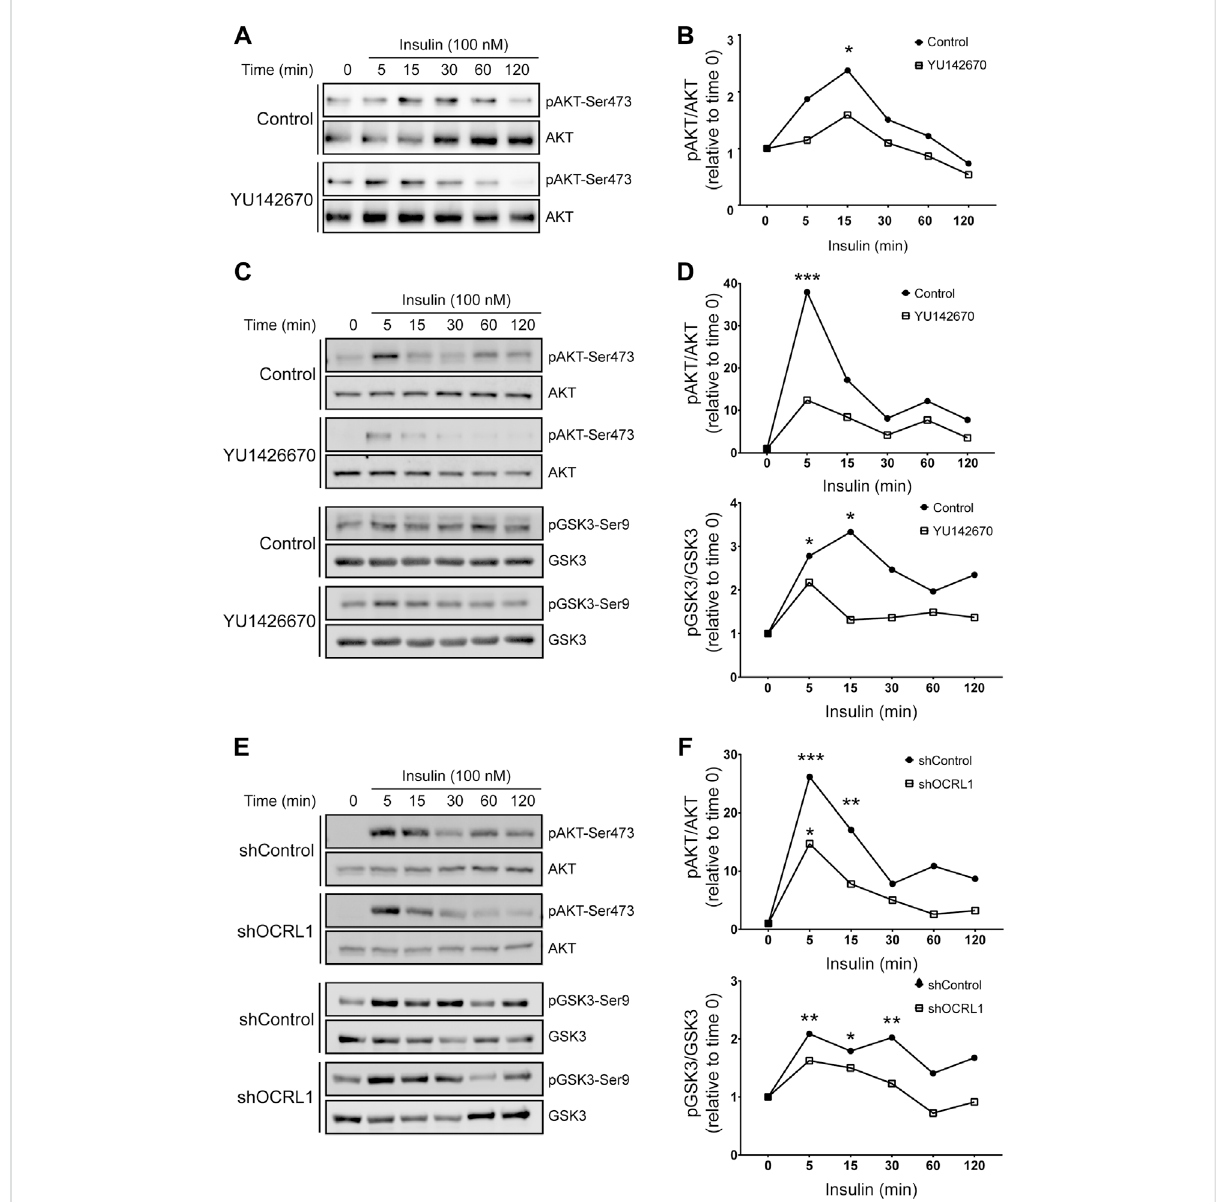
FIGURE 7 Insulin signaling is decreased in LS cellular models. mMeg-LLC-PK1 (A – B) or HeLa (C – D) cells were serum starved for 4 h ± 50 μ M YU1426670 and then incubated with 100 nM insulin ± 50 μ M YU1426670 for indicated periods of time. (A,C) Cell lysates were analyzed by western blottodetecttotalandphosphorylated formsofAKT. (B) .Graphcorrespondsto theproteinlevels ofphosphorylated AKT corrected bytotallevels of AKT relative to time 0. N = 3; ANOVA, * p < 0.05. (D) Graph corresponds to the protein levels of phosphorylated protein corrected by total levels relativetocontrol,time0,AKT(upper)orGSK3 β (lower).N=3,ANOVA,*** p < 0.001,** p < 0.01,* p < 0.05. (E – F) HeLacontrolorOCRL1silencedcells were serum starved for 4 hand then incubatedwith 100 nM insulin ± 50 μ M YU1426670 for indicated periods of time. (E) Cell lysates wereanalyzed by western blot to detect total and phosphorylated forms of AKT and GSK3 β . (F) Graph corresponds to the protein levels of phosphorylated protein corrected by total levels relative to control, time 0, AKT (upper) or GSK3 β (lower). N = 3 ANOVA, *** p < 0.001, ** p < 0.01, * p <